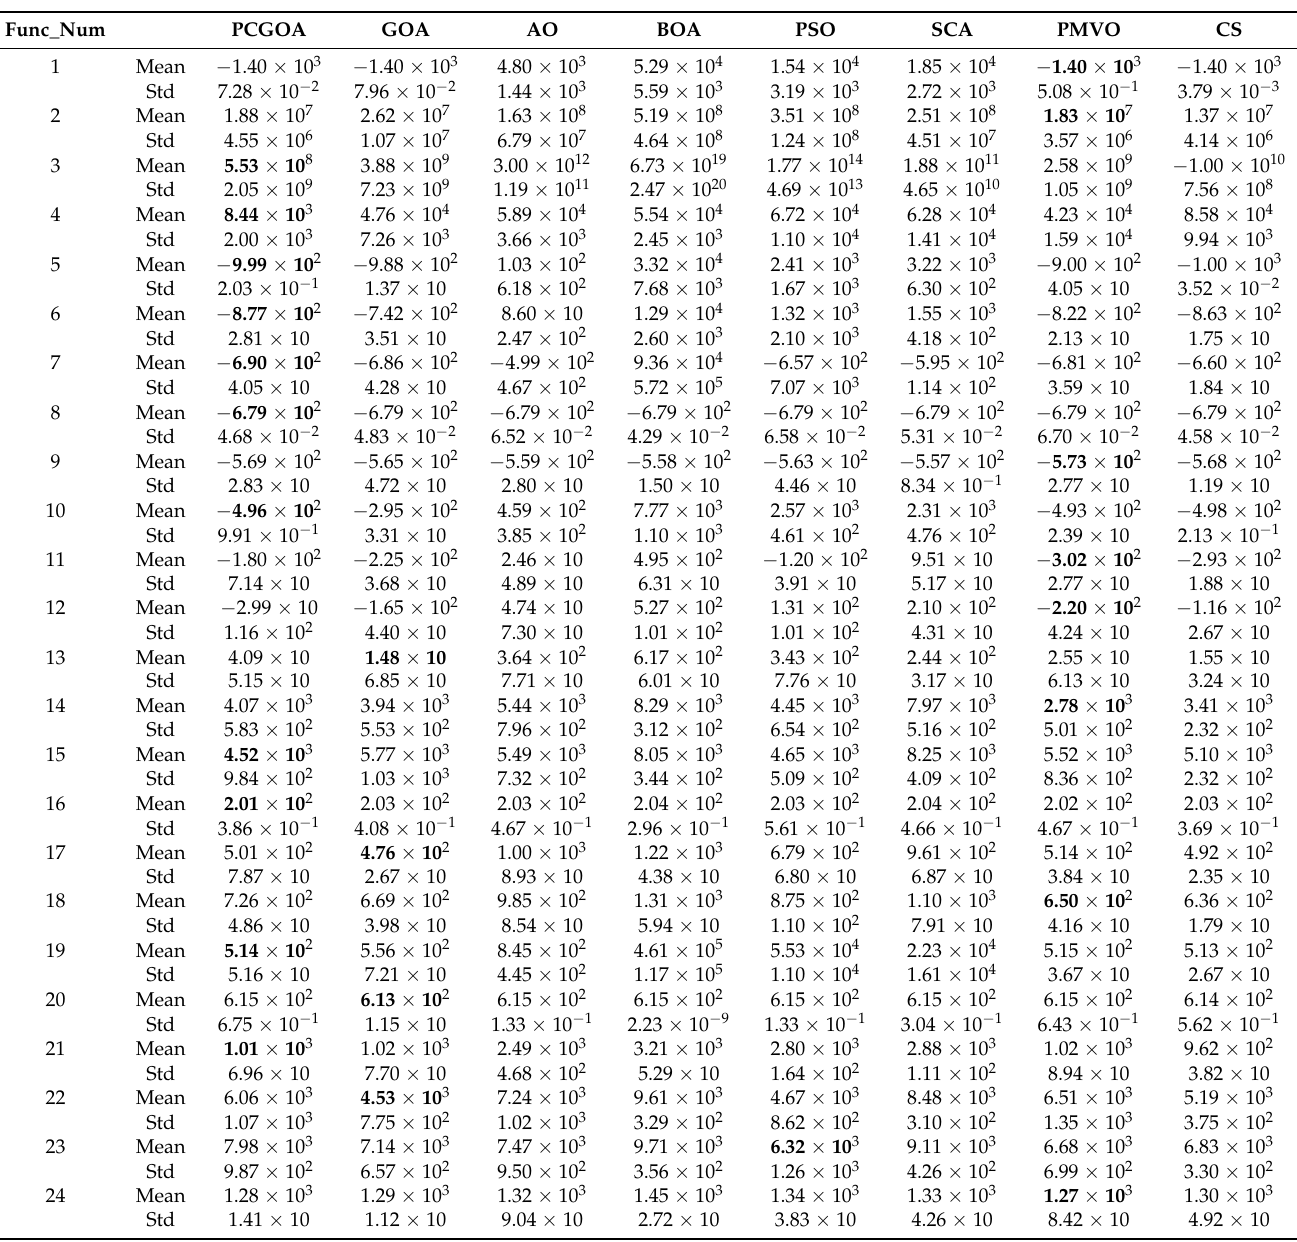
Table 1. Simulation results on